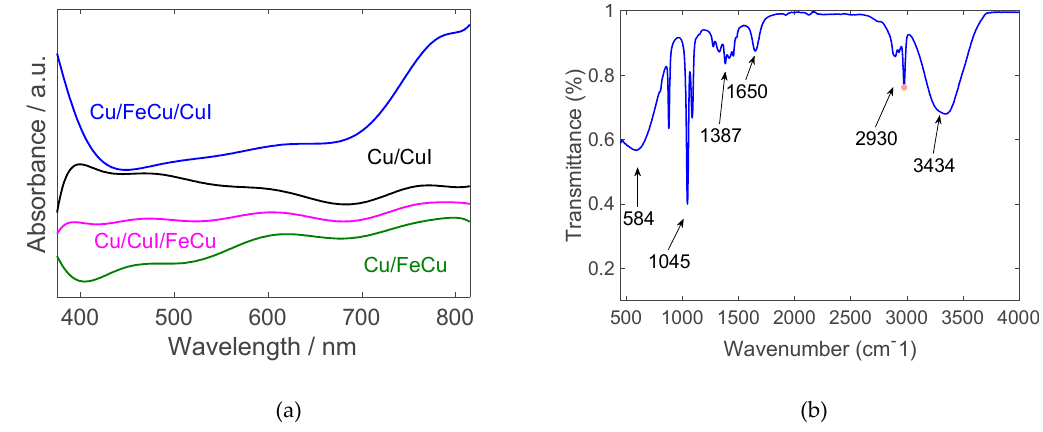
Figure 7. ( a ) Spectral absorptivity of produced electrodes and ( b ) FTIR spectra of the natural Figure 7. ( a )Spectralabsorptivityofproducedelectrodesand( b )FTIRspectraofthenaturalCalotropisdye. Calotropis dye.